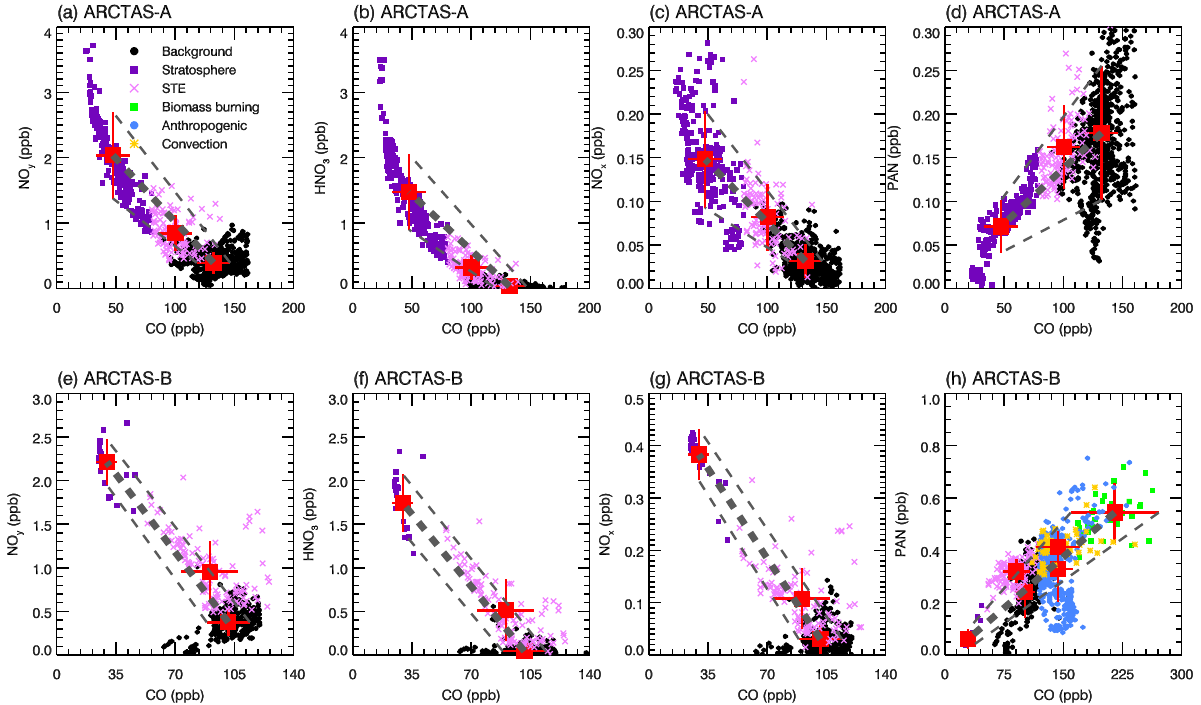
Fig. 6. Scatter plots of NO x , PAN, HNO 3 , and NO y vs. CO in the background air between 6-12km (black dots), stratospheric air (purple squares), and stratosphere-troposphere mixed air (lilac crosses) for ARCTAS-A (top panels) and ARCTAS-B (bottom row). The mean mixing ratios within each air mass is plotted (red squares) with horizontal bars indicating one standard deviation of CO and vertical bars for one standard deviation of the corresponding reactive nitrogen species. This figure demonstrates how trace gas mixing ratios change as air of stratospheric-origin mixes with background air during STE. Note in panel (h) we have added the biomass burning, anthropogenic and convective air masses between 6–12km as well to demonstrate the impact on PAN in the stratosphere-troposphere mixed air if mixing with these tropospheric air masses occurs. For air that do not experience active chemical production and loss of reactive nitrogen species, as well as wet scavenging (important for HNO 3 , and therefore NO y ) , an air parcel should in general follow the mixing line (thick gray dashed lines) as it descends into the troposphere. The thin gray dashed lines outline the envelope of mixing lines when allowing one sigma deviation from the mean concentration in both the stratospheric air and tropospheric